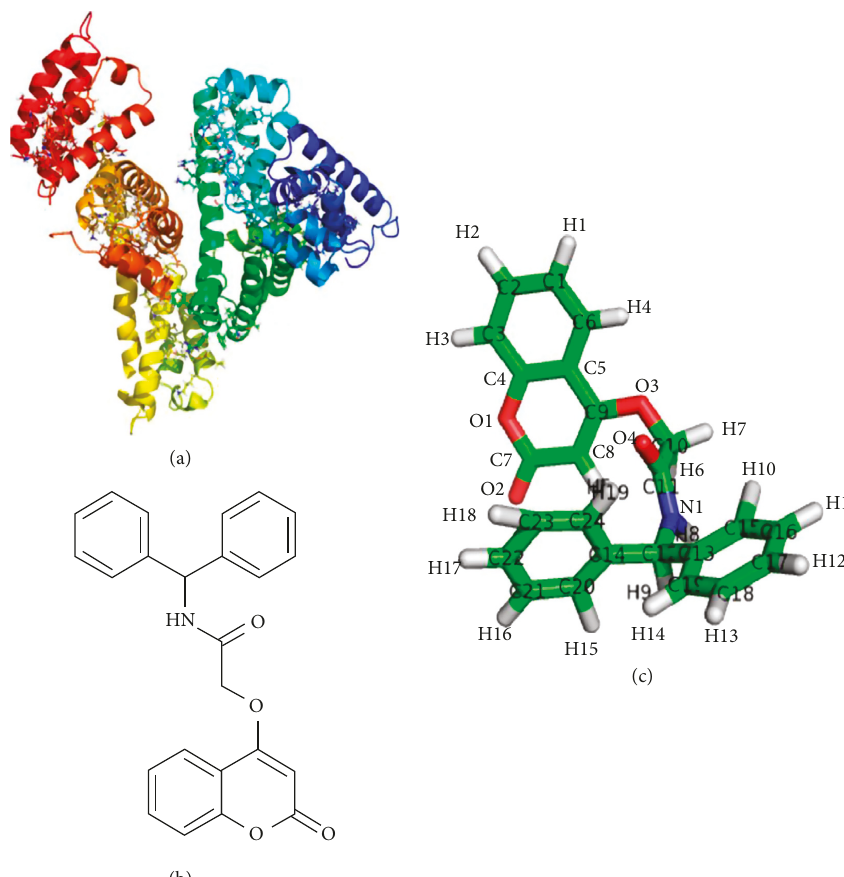
Figure 1: (a) Crystal structure of human serum albumin (PDB ID: 4L8U). (b) Chemical structure of the coumarin derivative. (c) Pymol view of the energy-minimized structure of the coumarin